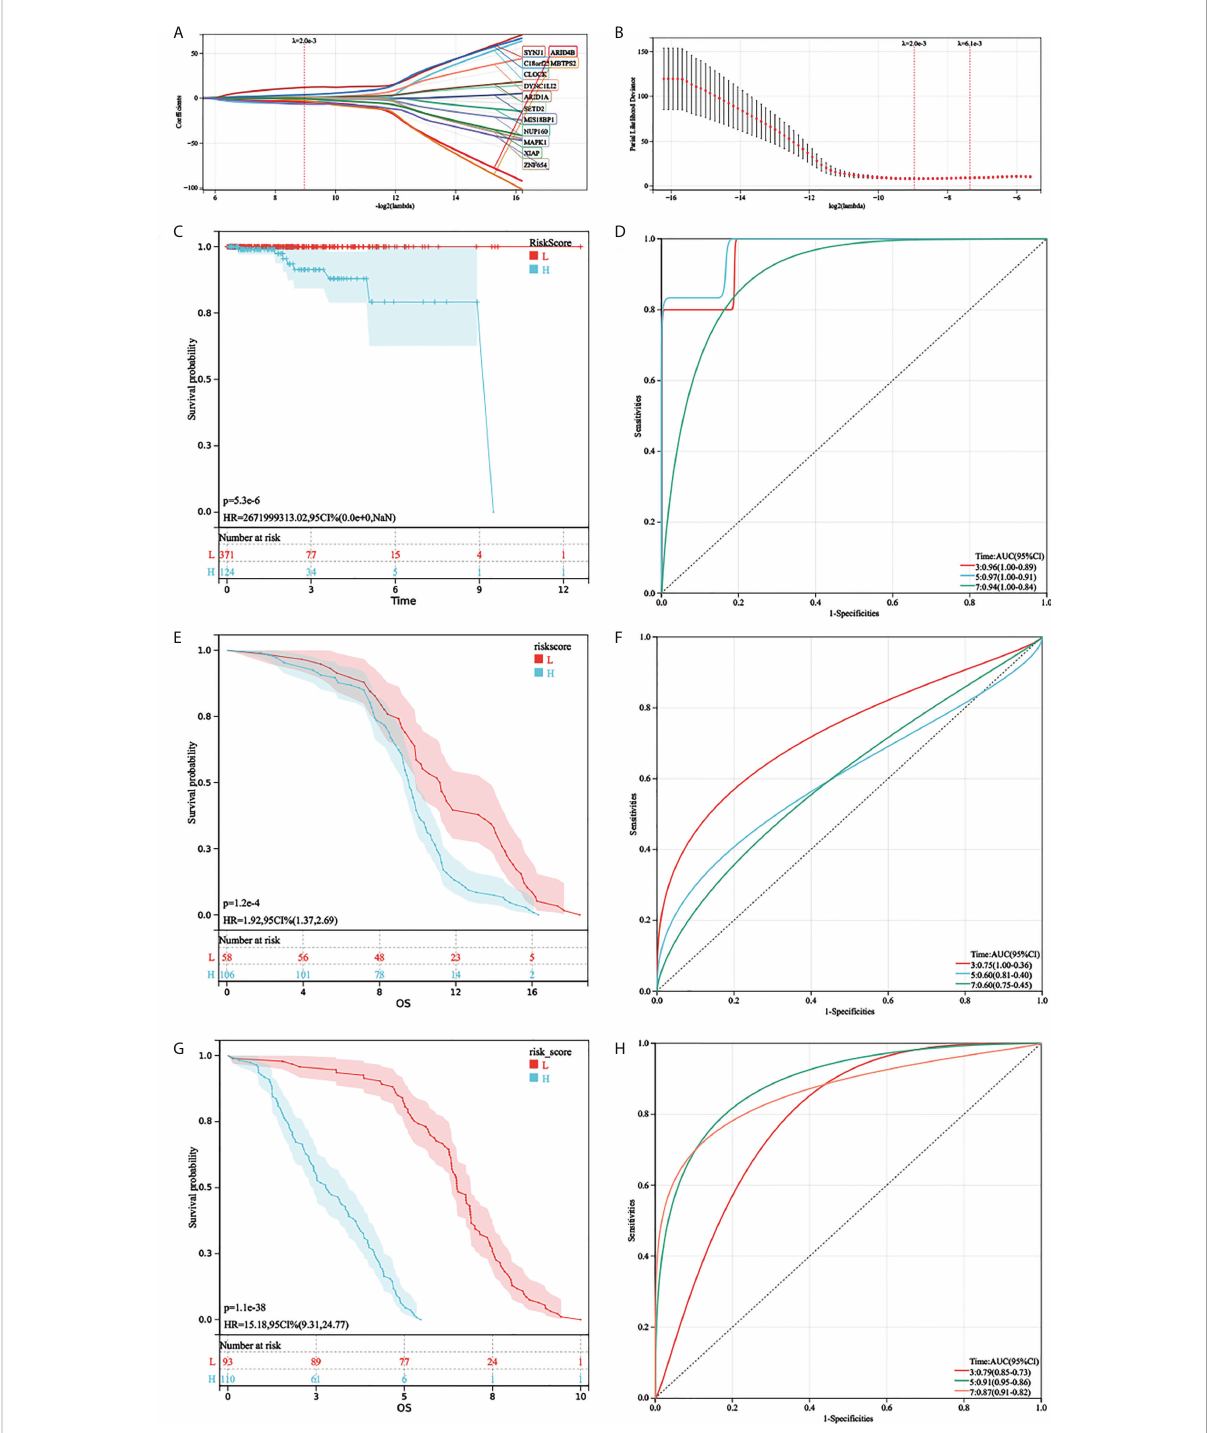
FIGURE 4 Development and validation of AGRS in TCGA-PRAD cohort. (A, B) The LASSO Cox regression algorithm was used to identify the most robust prognostic genes. (C, D) Patients were divided into high-risk and low-risk subgroups based on best cutoff. Kaplan – Meier analysis demonstrated that patients with higher AGRS exhibited worse overall survival in TCGA-PRAD, ROC curves showing the predictive ef fi ciency of the AGRS on the 3-, 5-, and 7-year survival rate. (E, F) Kaplan – Meier analysis and ROC curves in the GSE135160 cohort. (G, H) Kaplan – Meier analysis and ROC curves in the GSE70770